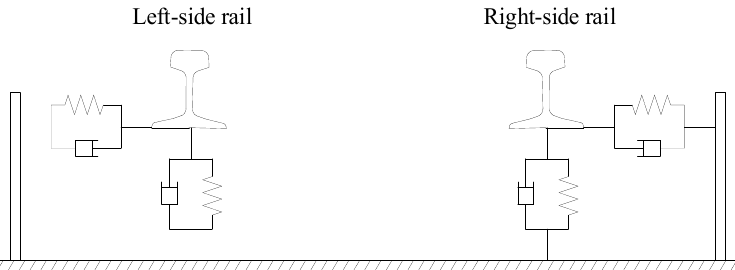
Figure 11. The lateral view of defect location on the left-side rail.